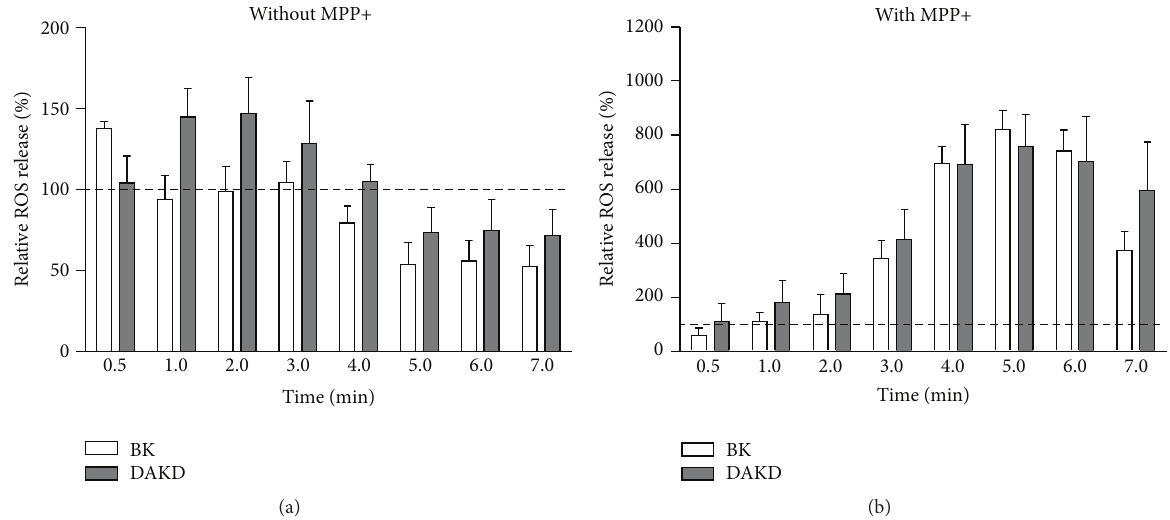
Figure 2: ROS production by differentiated SK-N-SH cells induced by kinin peptides. Cells (1.5 × 10 5 ) were previously incubated with kinin peptides for one day. Next, cells were loaded with DCFH2-DA and treated with 1 𝜇 M BK or 1 𝜇 M DAKD without (a) or in the presence of 2.5 mM MPP+ (b), as described in Materials and Methods. The fluorescence signal was measured for 20 minutes. The figures describe the changes of ROS production as compared with cells untreated with kinin peptides, assumed to show 100% of ROS release (dashed line). At least three experiments were performed in